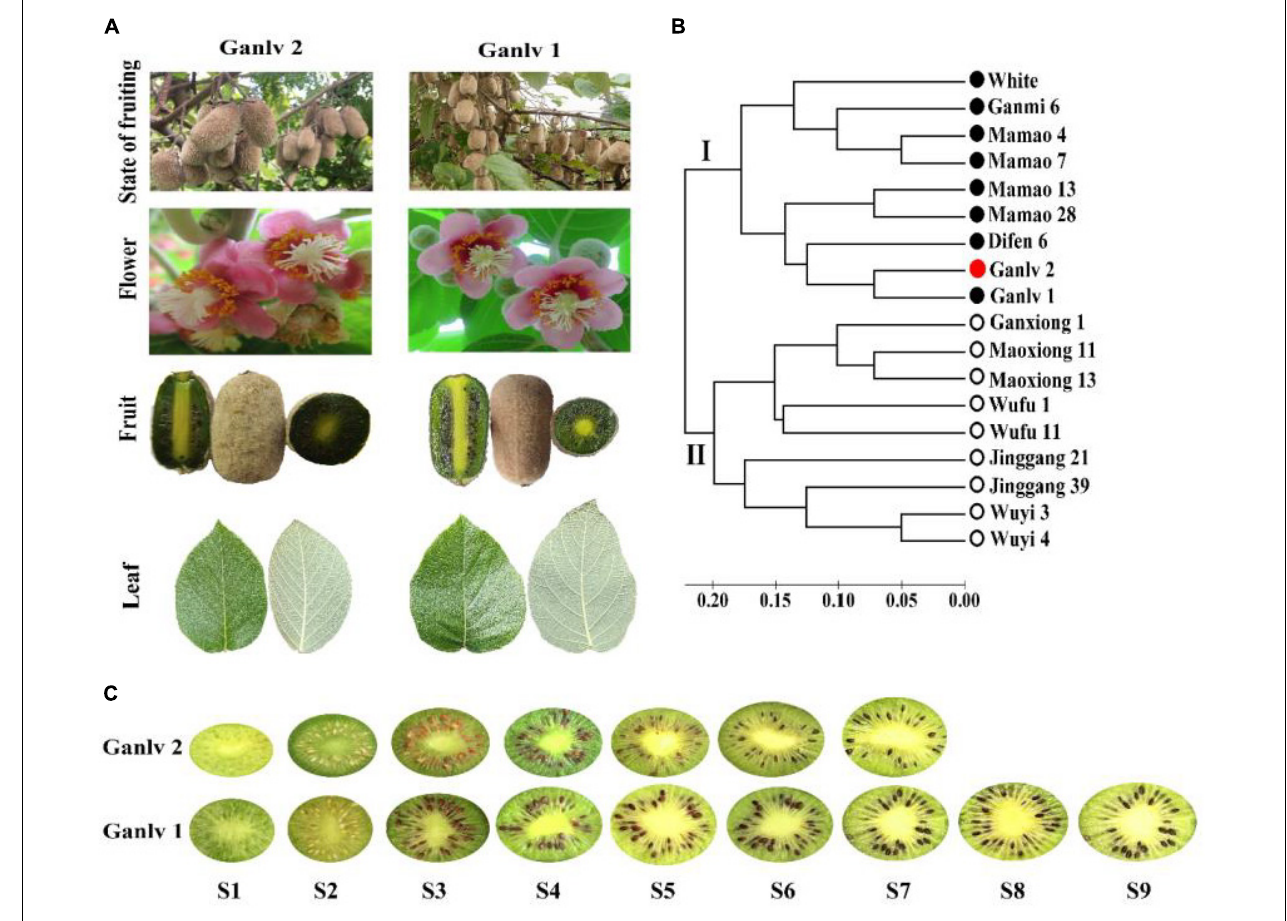
FIGURE 1 | Test materials (A) ‘Ganlv 1’ and ‘Ganlv 2’ had similar botanical traits and flowering stages; (B) Simple sequence repetition (SSR) technology was used for genetic similarity coefficient analysis, and the genetic similarity coefficient value of test materials was less than 0.08, the bar at the bottom is the bar of genetic similarity coefficient, the solid circle represents the female germplasm, the hollow circle represents the male germplasm, and ‘Ganlv 2’ was marked in red; (C) Fruit developmental stages and sampling time points of ‘Ganlv 2’ and ‘Ganlv 1’, the early mature germplasm ‘Ganlv 2’ had reached the commercial harvested standard at